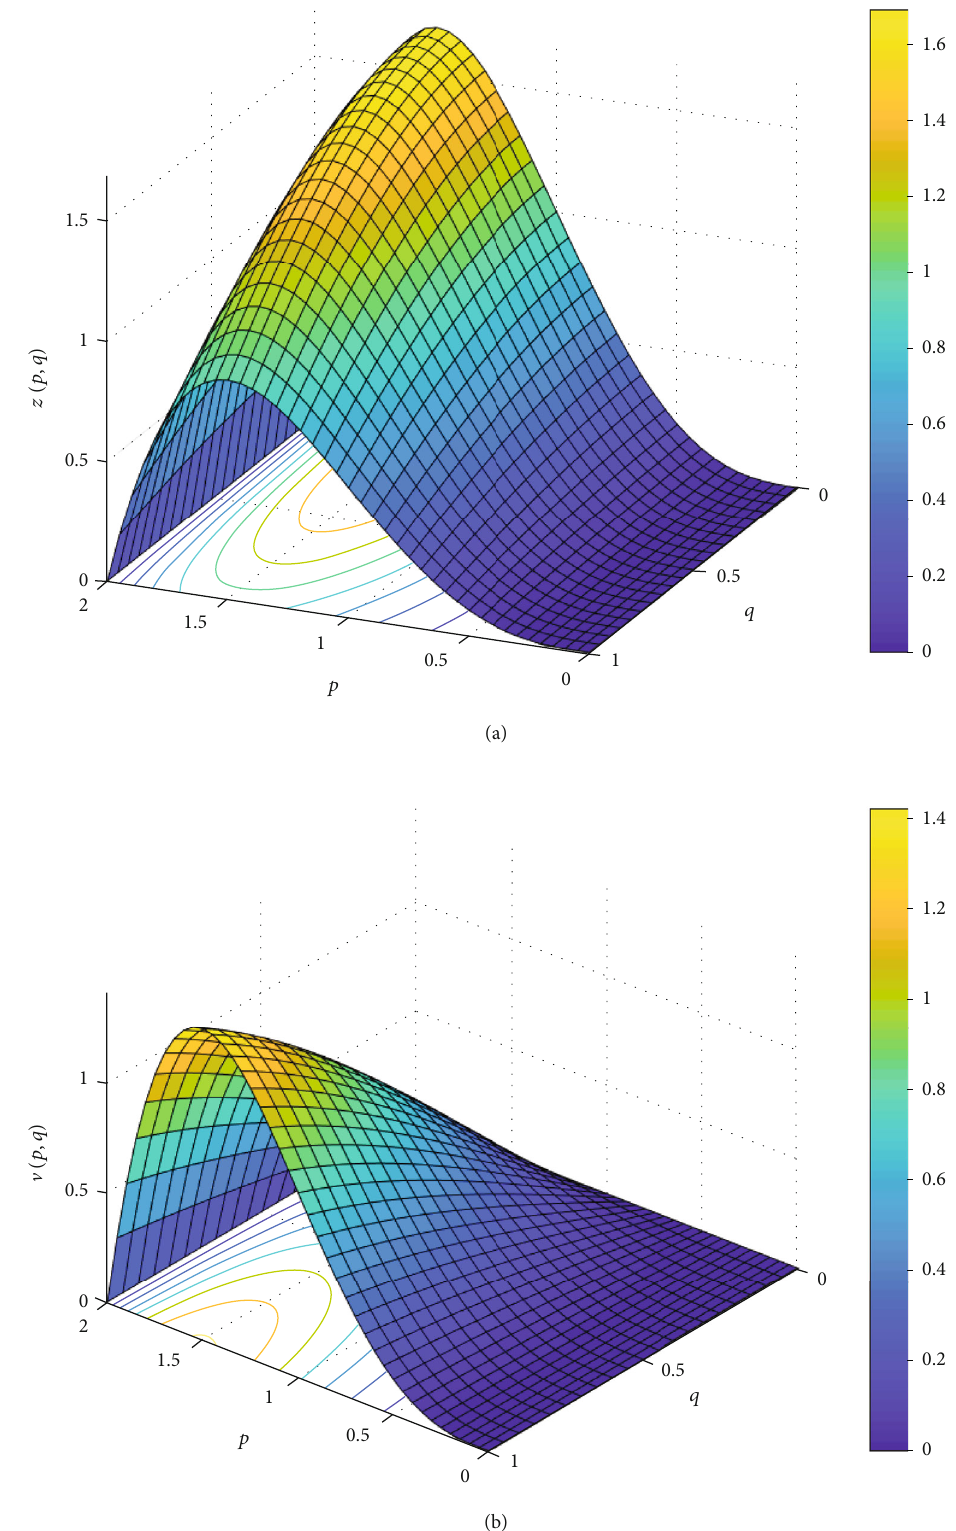
Figure 5: Numerical solution of z ð p , q Þ , v ð p , q Þ with ρ = ω = υ = 1 for Example 9 when m = 6